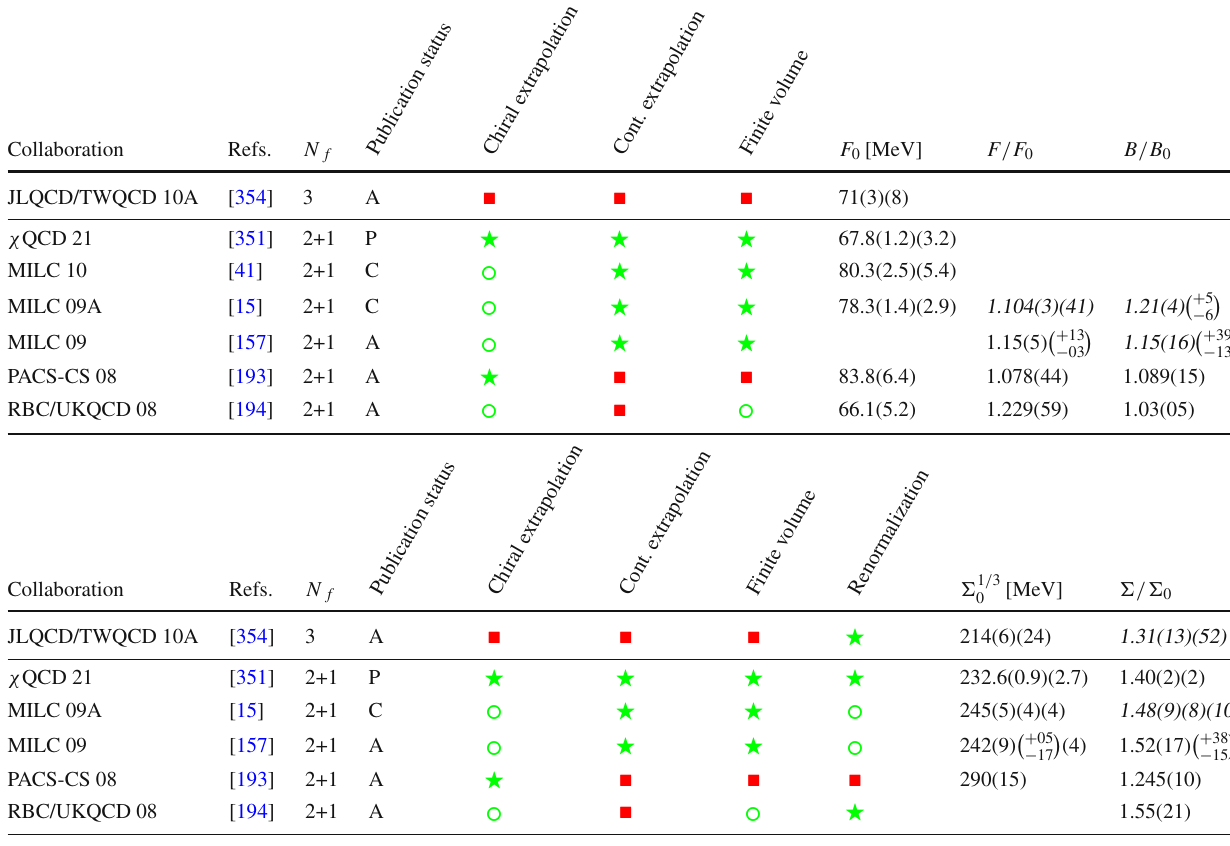
B 0 , which specify the effective SU ( 3 ) Lagrangian at leading order. 0